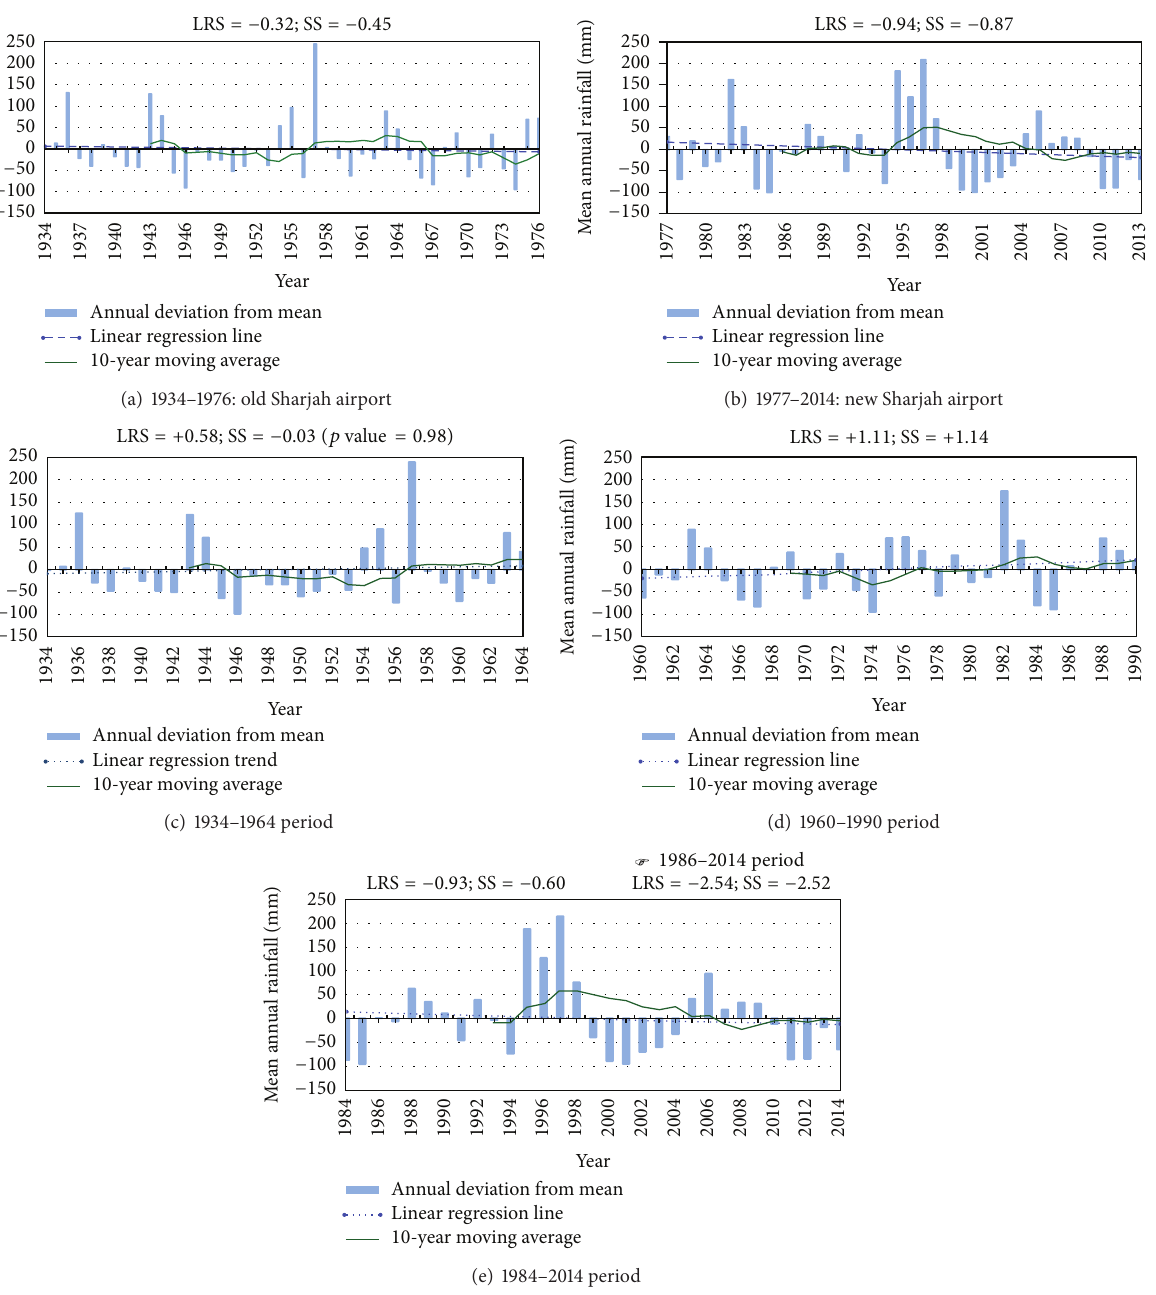
Figure 5: Mean annual precipitation and equivalent linear regression trend line and 10-year moving average line plotted for the